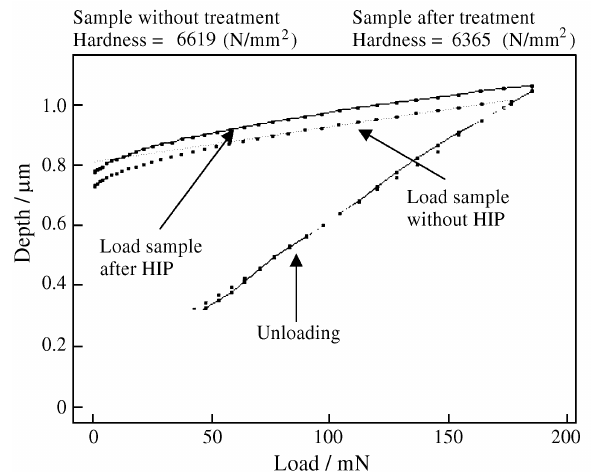
Figure 1. Depth reached by the indenter versus applied load for hardness measurement - maximum depth 1 µ m.